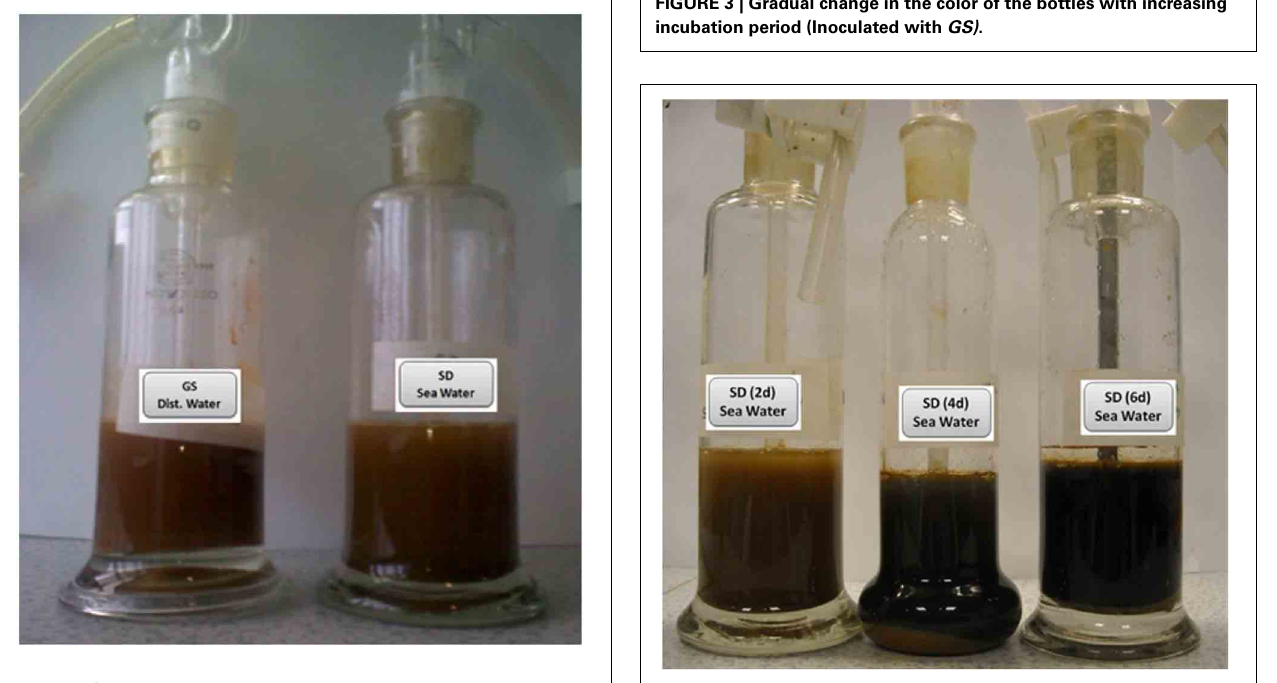
FIGURE 4 | Gradual change in the color of the bottles with increasing incubation period (Inoculated with SD)